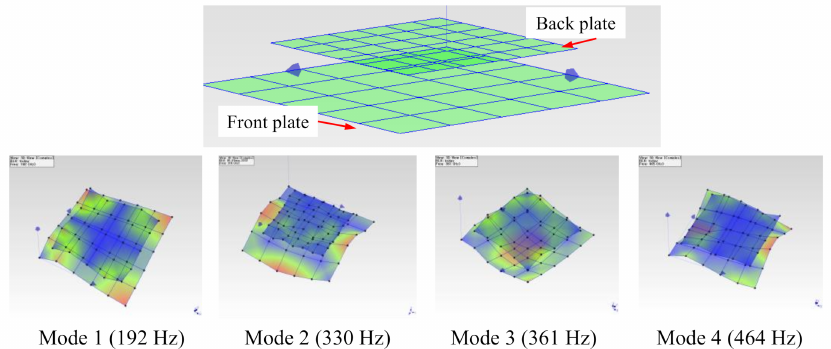
Figure 12. Mode shapes of the healthy fully-assembled TPS panel corresponding to the first four natural frequencies.